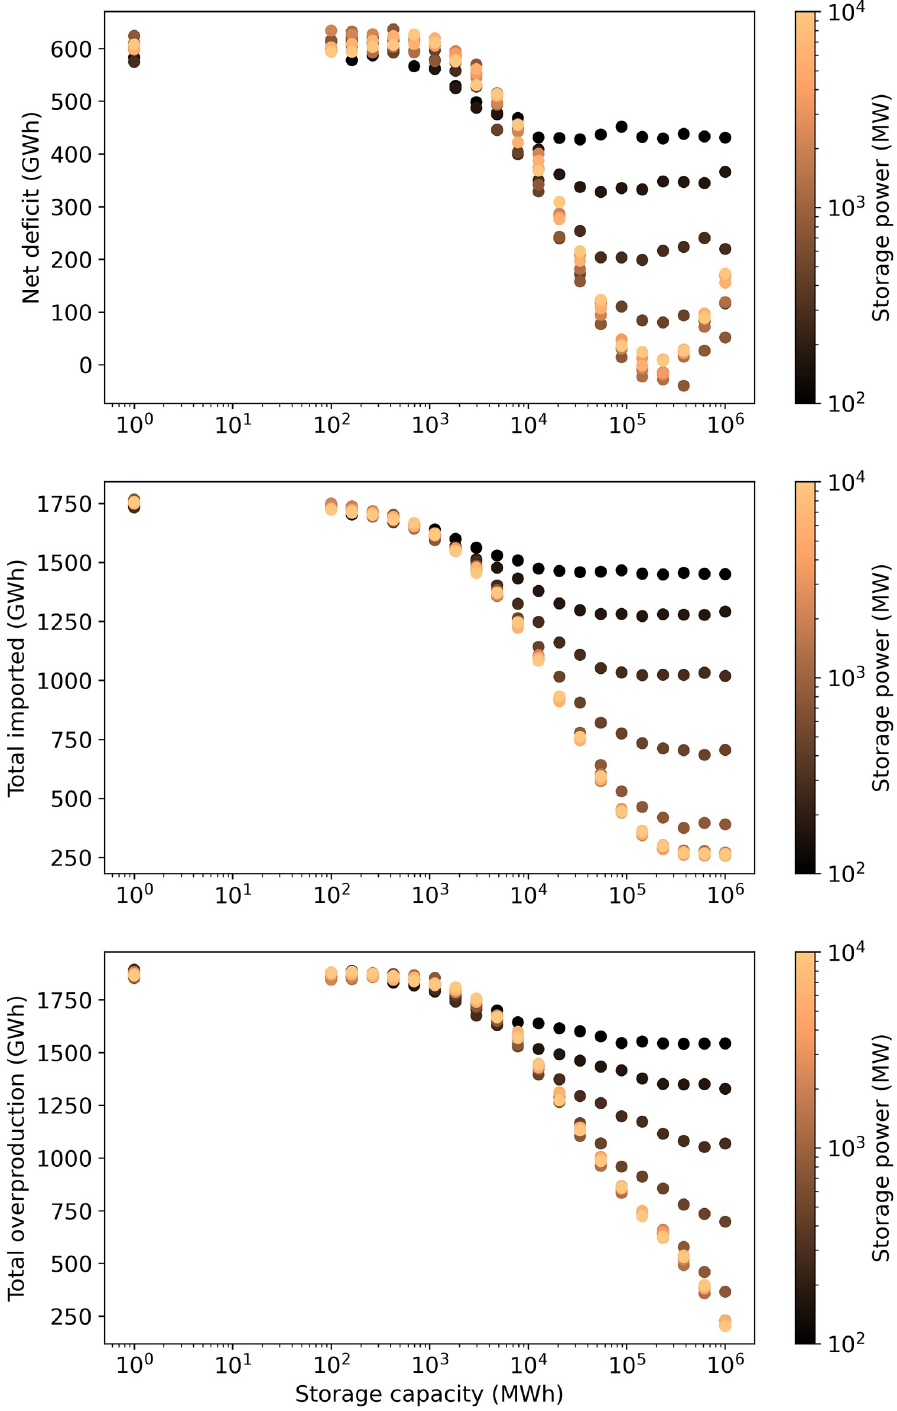
Fig 4. Estimated effect of storage capacity and power on Estonia’s annual electricity balance.